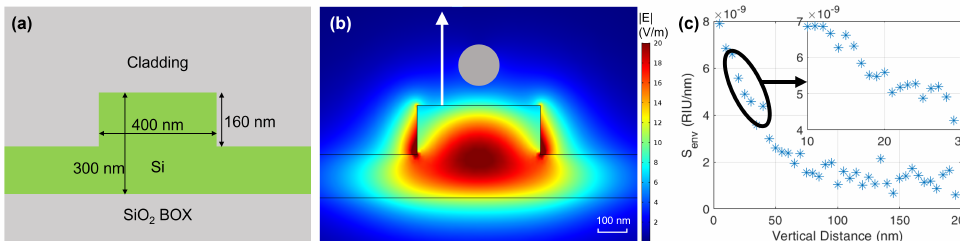
Figure 2. ( a ) Cross section and dimensions of the silicon photonic waveguide. ( b ) Transverse electric field distribution of the fundamental TE mode. ( c ) Environmental sensitivity S env extracted from numerical simulation for an MNP in the proximity of the waveguide. Inset: S env around 20nm MNP − waveguide